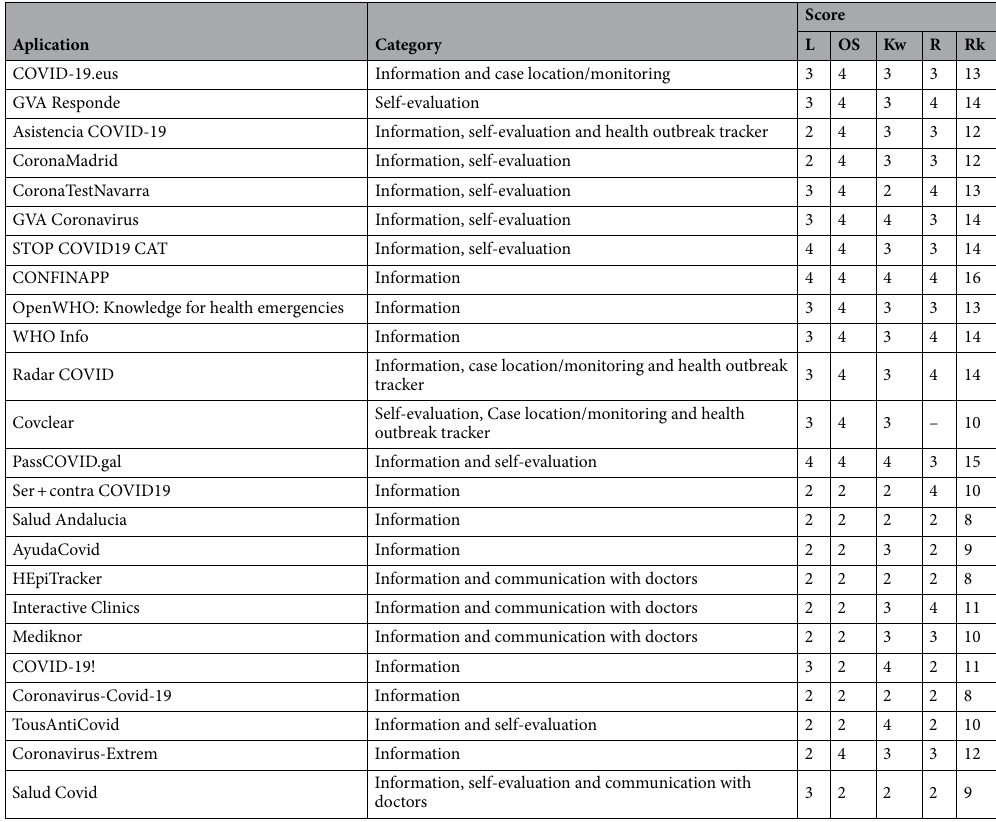
Table 2. Categories and scores obtained by each app in the